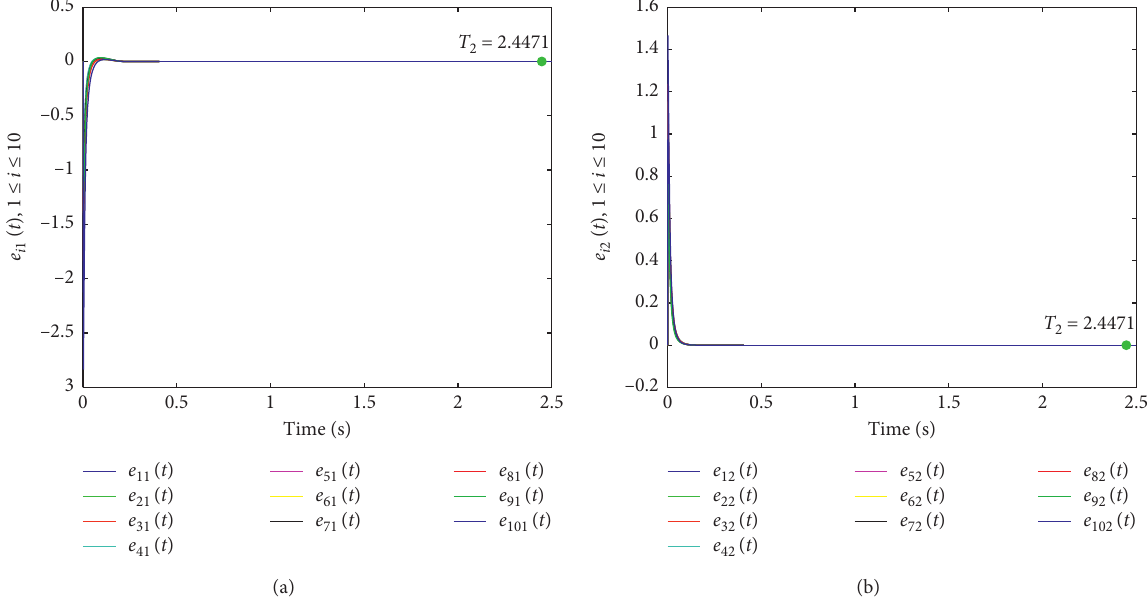
( t )( i � 1 , 2 , ... , 10 ) . (b) e ( t )( i � 1 , 2 , ... , 10 ) i 1 i 2